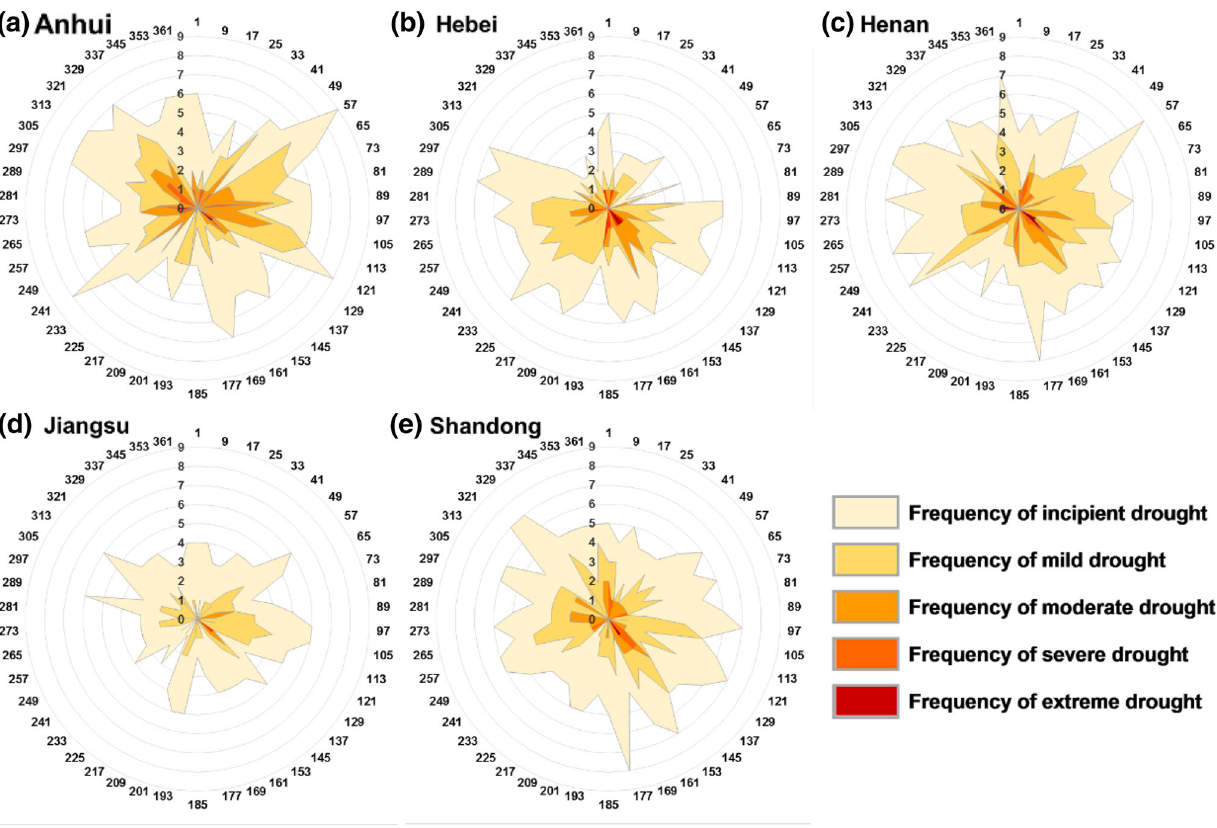
Fig. 4 Temporal distribution of frequency of droughts with different intensities in Anhui, Hebei, Henan, Jiangsu, and Shandong Provinces, China,